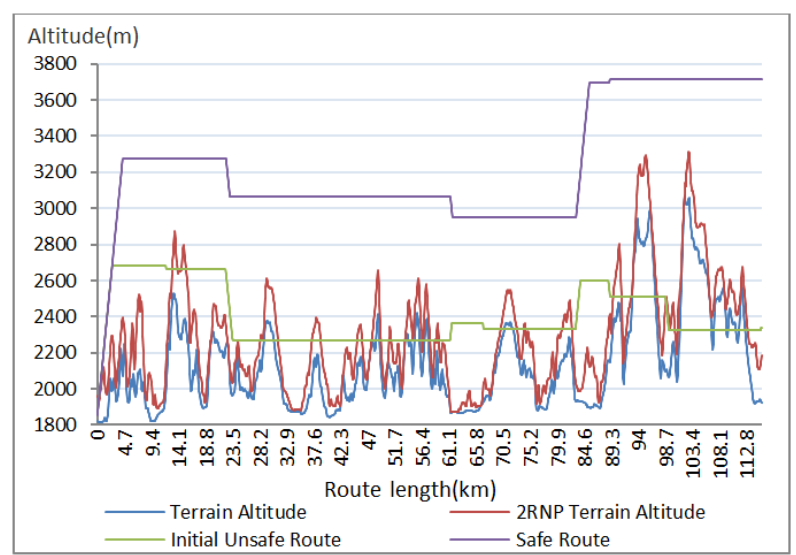
Figure 18. Vertical flight path.